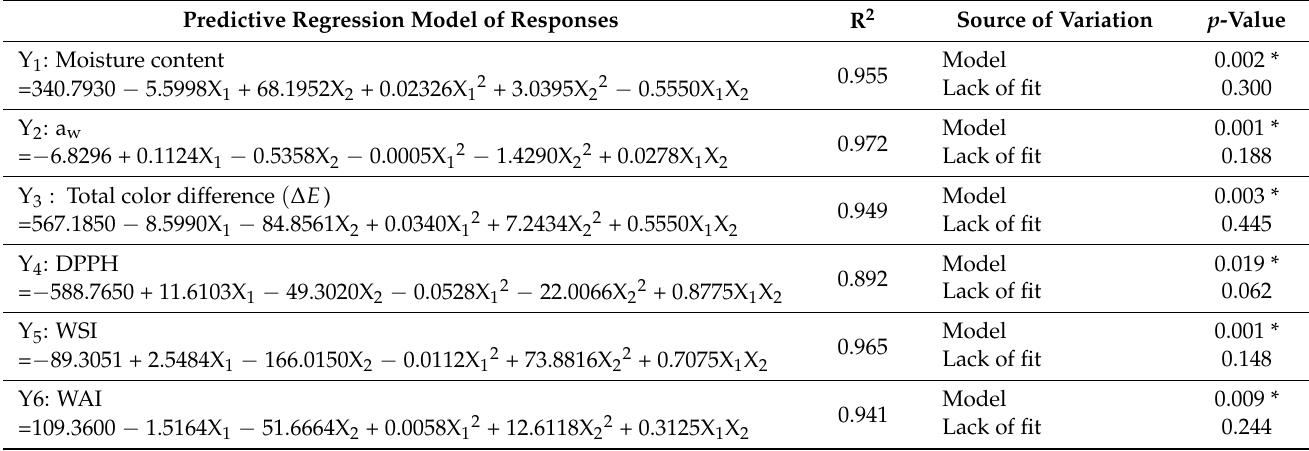
Table 3. ANOVA (analysis of variance) of the dependent variable predictive regression